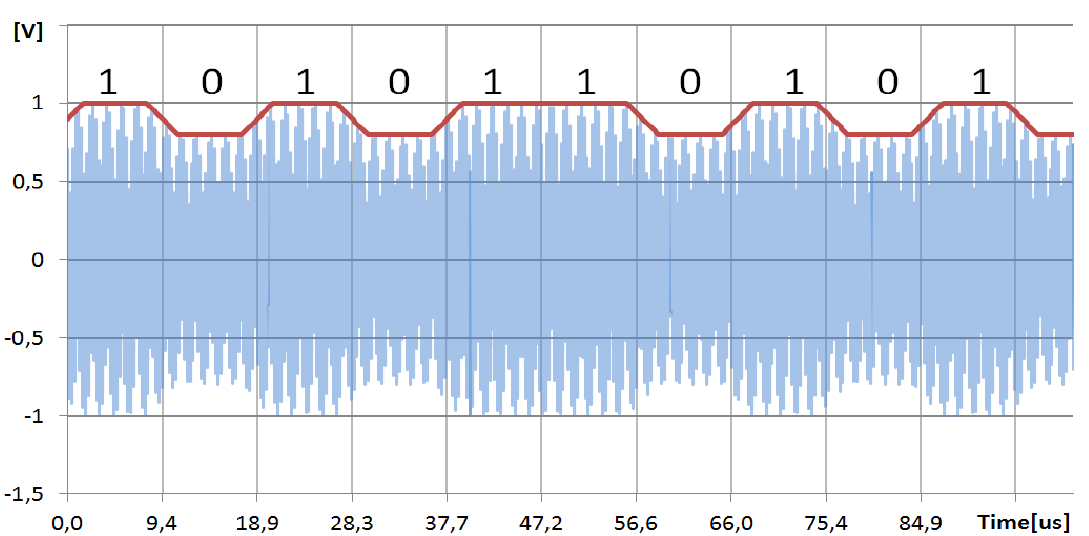
Figure 2. Oscillogram of PID to PICC communication via ~10% amplitude modulation. Logic Zero is represented by low amplitude, logic one is by high amplitude of the carrier (13.56 MHz).